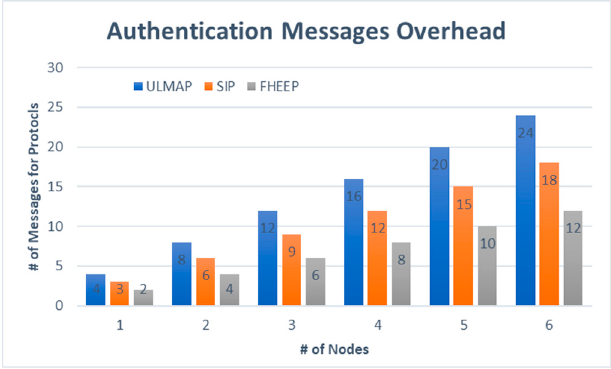
Figure 5. Showing the Messages overhead for no of nodes.